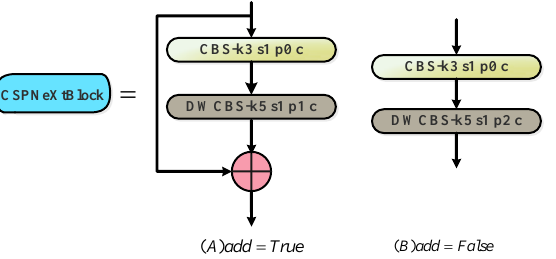
Figure 6. The CSPNeXt Block framework is divided into two different structures, A and B, according to whether add is True or False.